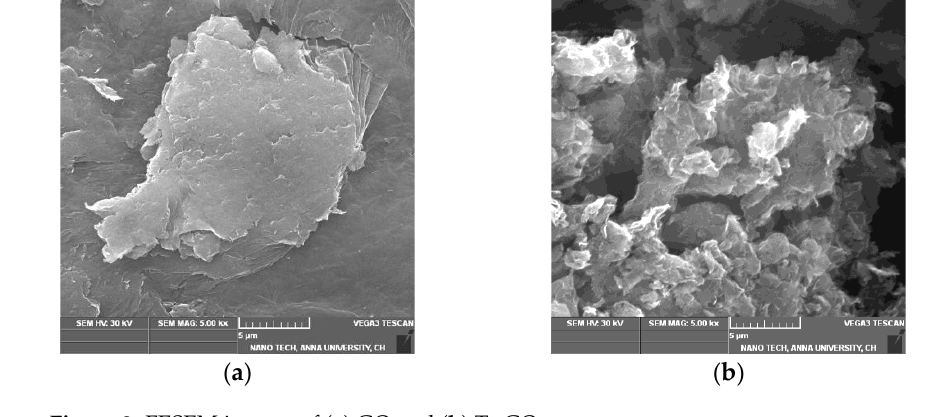
Figure 2. FESEM images of ( a ) GO and ( b ) T-rGO.